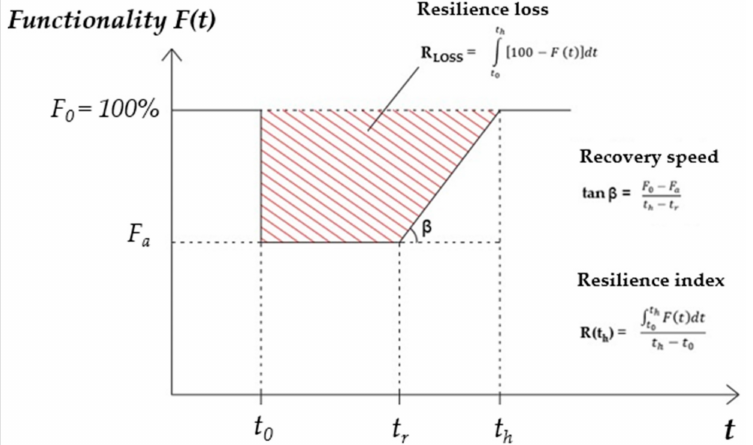
Figure 4. Schematic functionality recovery curve: resilience loss, recovery speed, and resilience